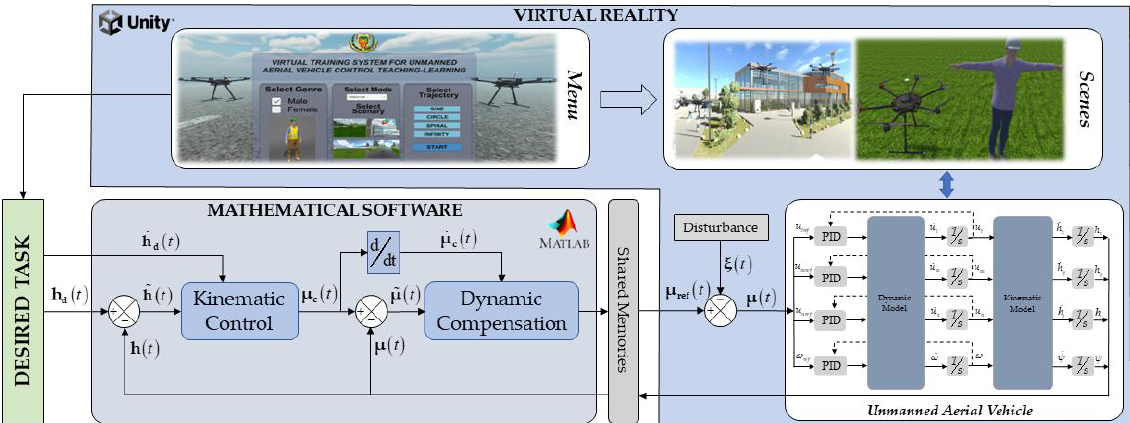
Figure 5. Velocities obtained from the dynamic model of the DJI Matrice 600 Pro, with the previ- ously identified dynamic parameters, closely resemble the real UAV velocities behavior during its experimentation. ( a ) Validation scheme; ( b ) Velocity signals comparison.